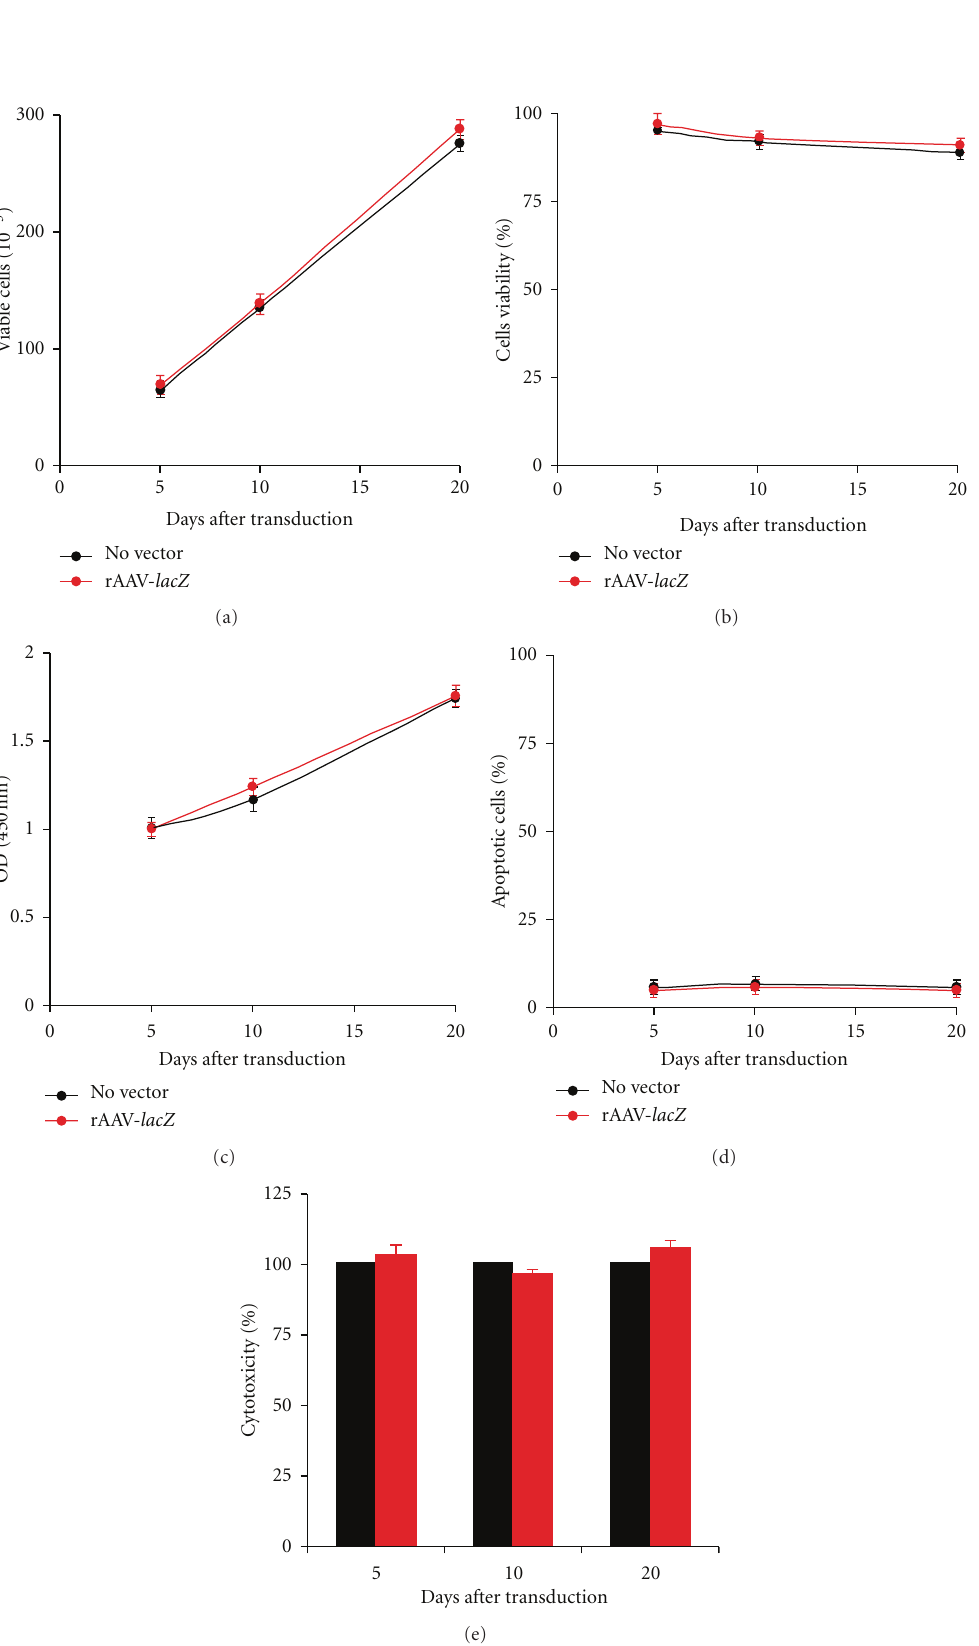
Figure 3: E ff ects of rAAV-mediated gene transfer on the survival of transduced primary human chondrosarcoma cells in vitro . Cells in monolayer culture were transduced as described in Figure 1 or let untreated for up to 20 days to monitor the viable cell numbers (a), cell viability (b), the rates of proliferation (WST-1 assay) (c), the levels of apoptosis (TUNEL assay) (d), and potential cytotoxic responses to the treatment by rAAV (Cytotoxicity Detection Assay LDH)